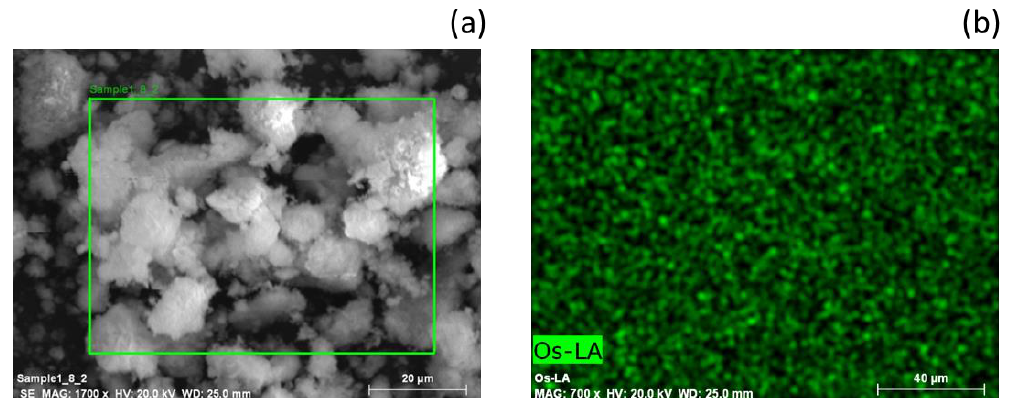
Figure 2. Surface morphology of Os – HTlc ( a ) and EDX mapping of Os in the Os – HTlc catalyst ( b ).